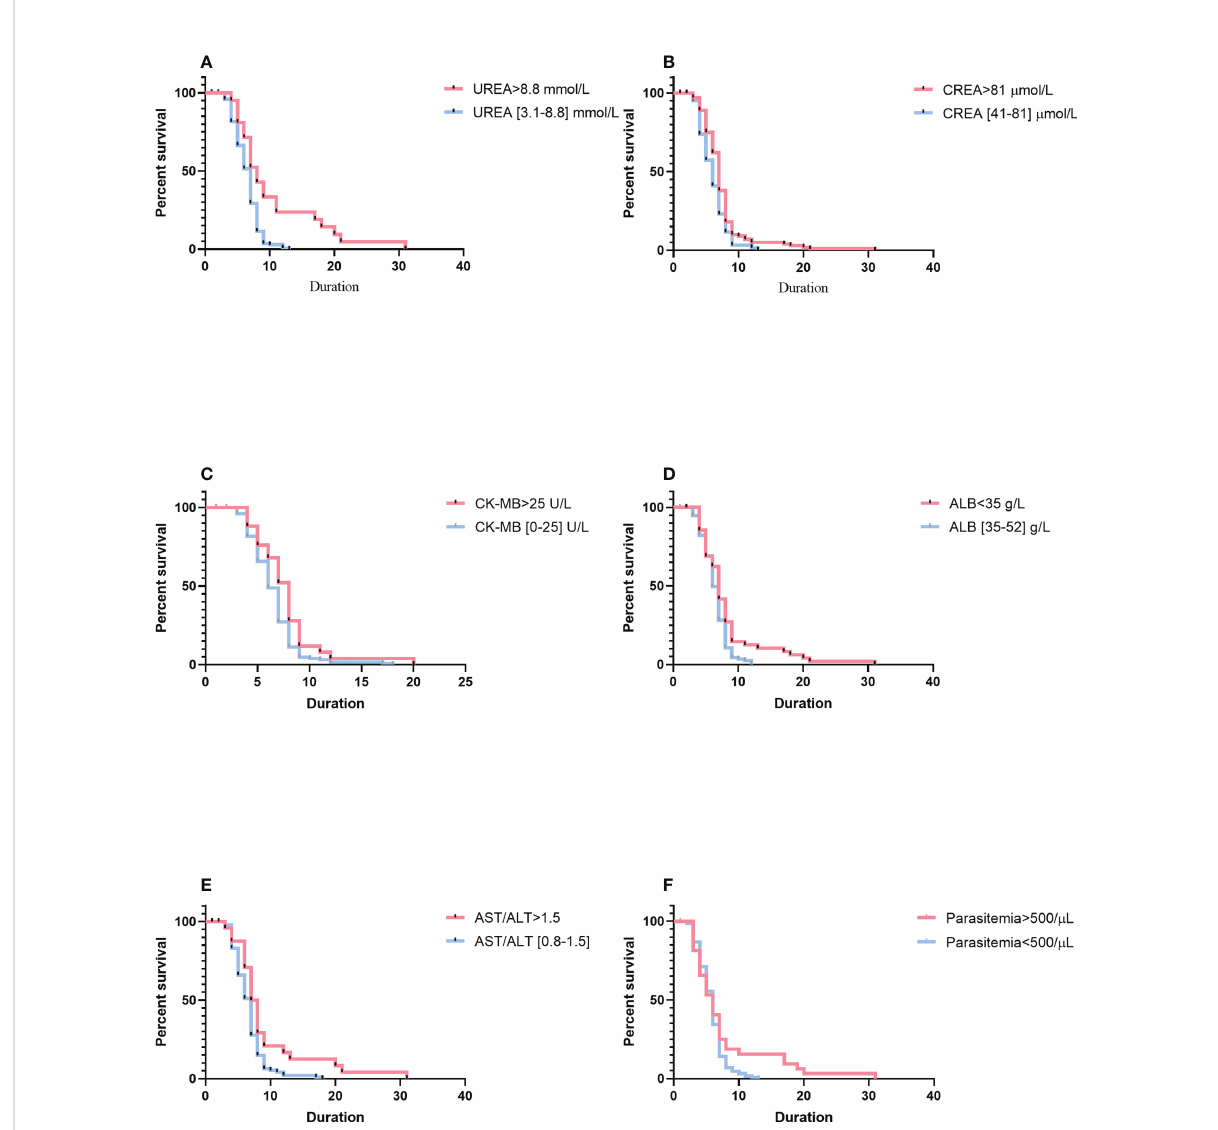
FIGURE 2 Comparison of survival curves using the log-rank test. (A) Serum higher levels of UREA versus within the normal reference range. (B) of CREA versus within the normal reference range. (C) Serum higher levels of CK-MB versus within the normal reference range. (D) Serum lower levels of ALB versus within the normal reference range. (E) Serum higher levels of AST/ALT versus within the normal reference range. (F) Higher parasitemia versus lower parasitemia. Blue lines show patients with a shorter duration of parasite clearance; red lines show patients with a longer duration of parasite clearance. Duration is indicated in days. CREA, creatinine; CK-MB, creatine kinase isoenzyme-MB; ALB, albumin; AST/ ALT, aspartate aminotransferase-to-alanine aminotransferase